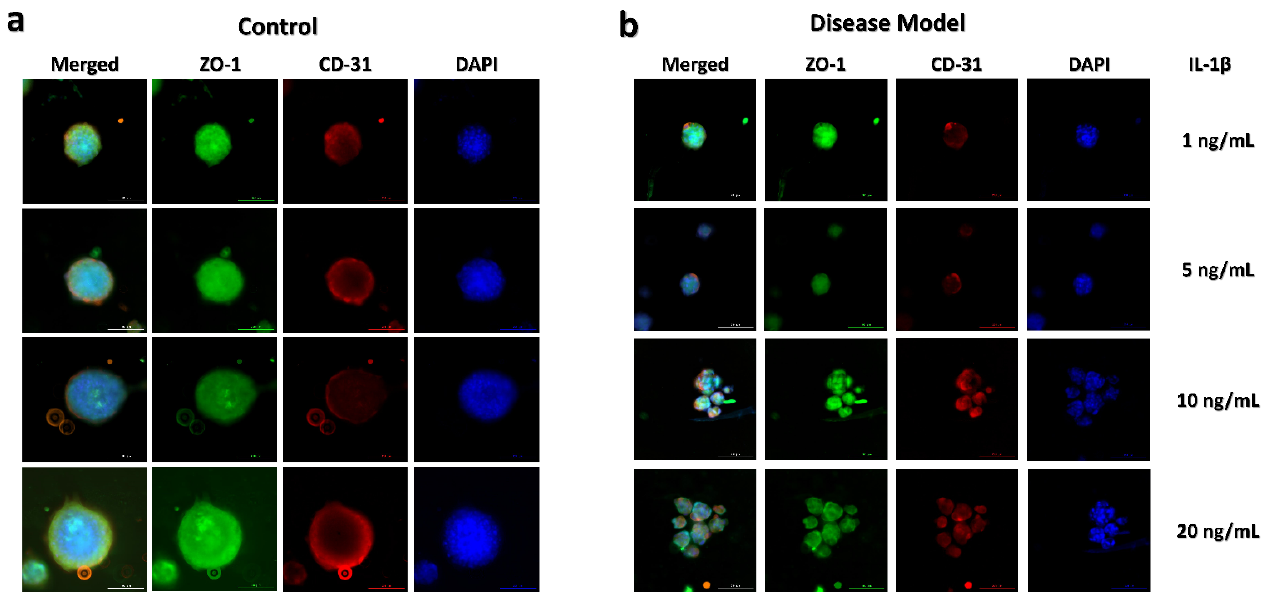
Figure 6. End-point expression of the ZO-1 tight junction and CD31 expression in disease model spheroids cultured in media with IL-1 β (stimulant) versus control spheroids cultured with normal media (no stimulant) at Day 7. ( a ) Representative images of multi-staining results of 20,000 cell concentration for control samples in which spheroid formation has good ZO-1 expression in HepG2 cell line (epithelial cells) and CD31 expression in HUVECs (endothelial cells). ( b ) Representative images of disease model condition (IL-1 β ) treated spheroid showing different cluster formation but automatically overcome the inflammatory condition, spheroids were exposed to four different concentrations of IL-1 β , i.e., 1, 5, 10, and 20 ng/mL for 5 days to cause cellular stress leading to the inflammatory disease model. ZO-1 is represented in green, CD31 is represented in red, blue staining represents nuclei (DAPI staining), and the three-color combination is a merged one. ZO-1 and CD 31 expression was comparatively lower than the control. (Scale bar: 200 μ m).